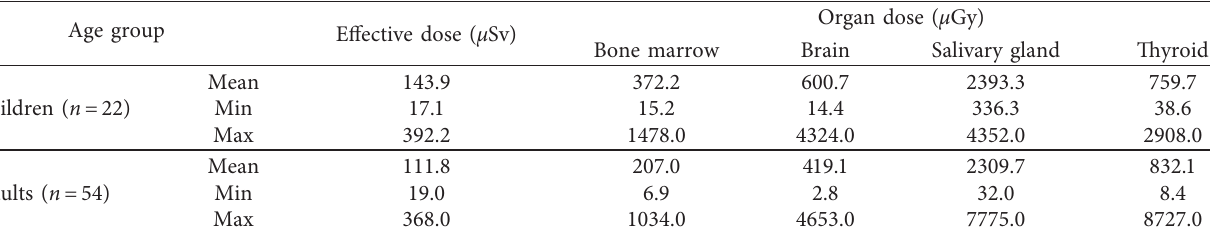
Table 6: Minimum, mean, and maximum values of effective and organ (bone marrow, brain, salivary gland, and thyroid) doses from cone- beam computed tomography procedures by age group (children and adults) reported in the selected publications.